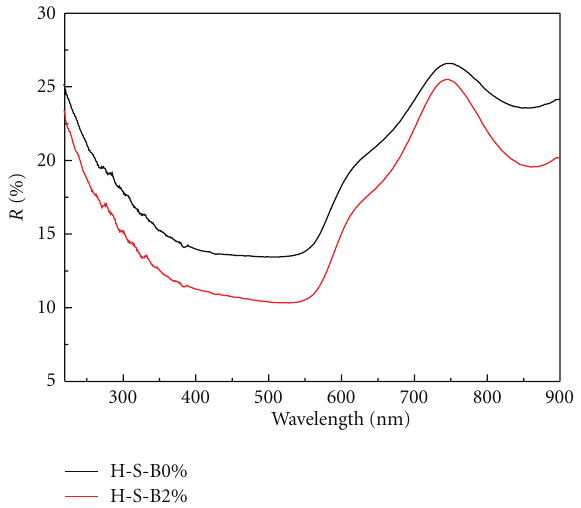
Figure 6: Atrazine degradation in present of hematite and B-doped hematite under visible